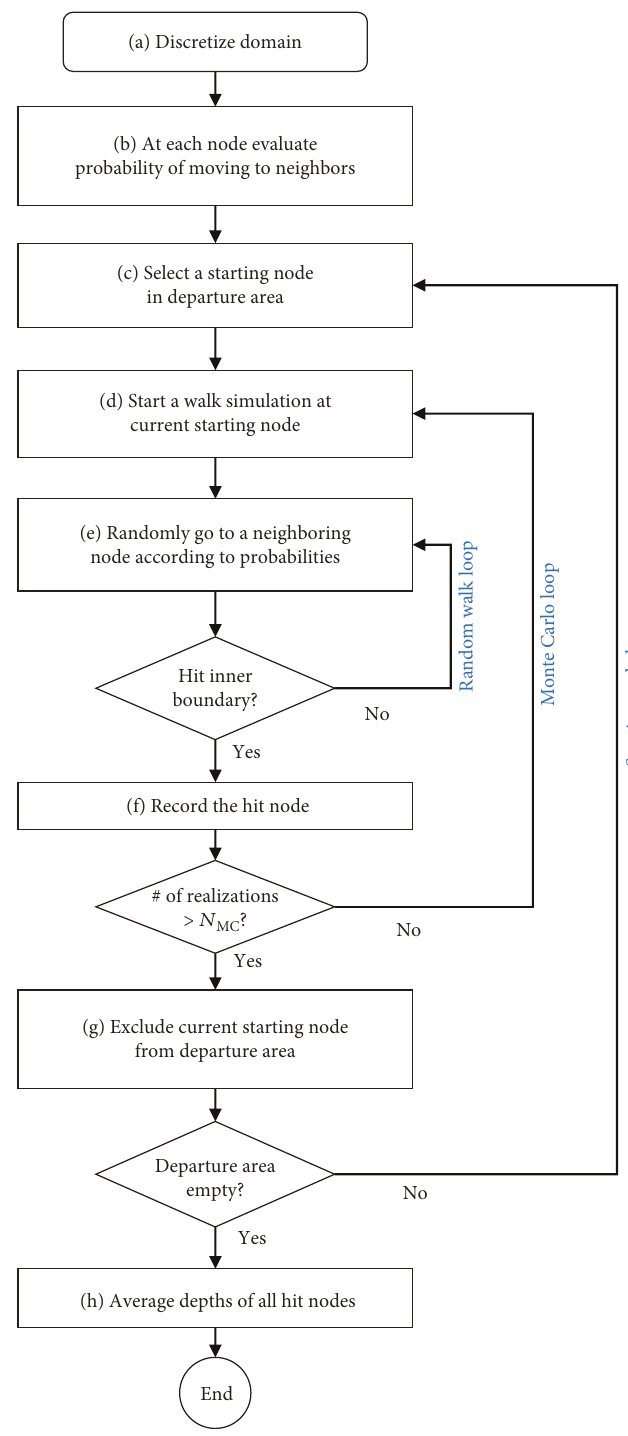
Figure 3: A fl owchart of the MPD estimation via